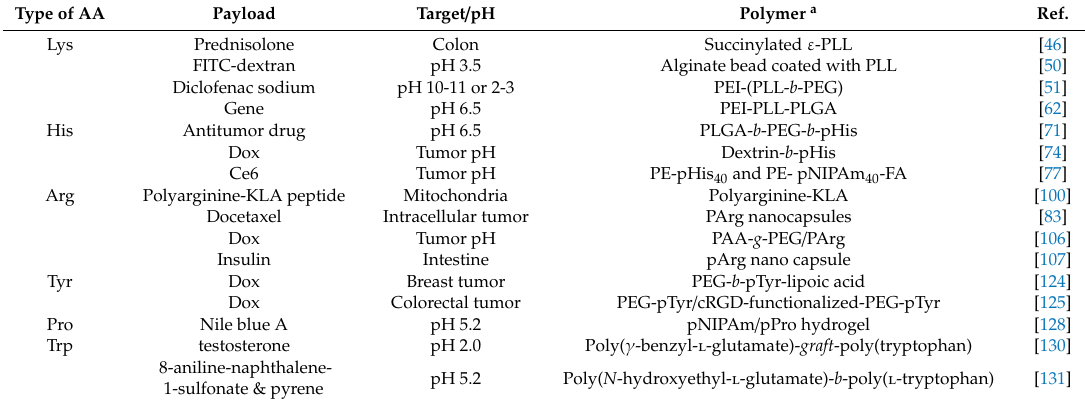
Table 2. Catonic amino acid derived polymers for pH-responsive drug